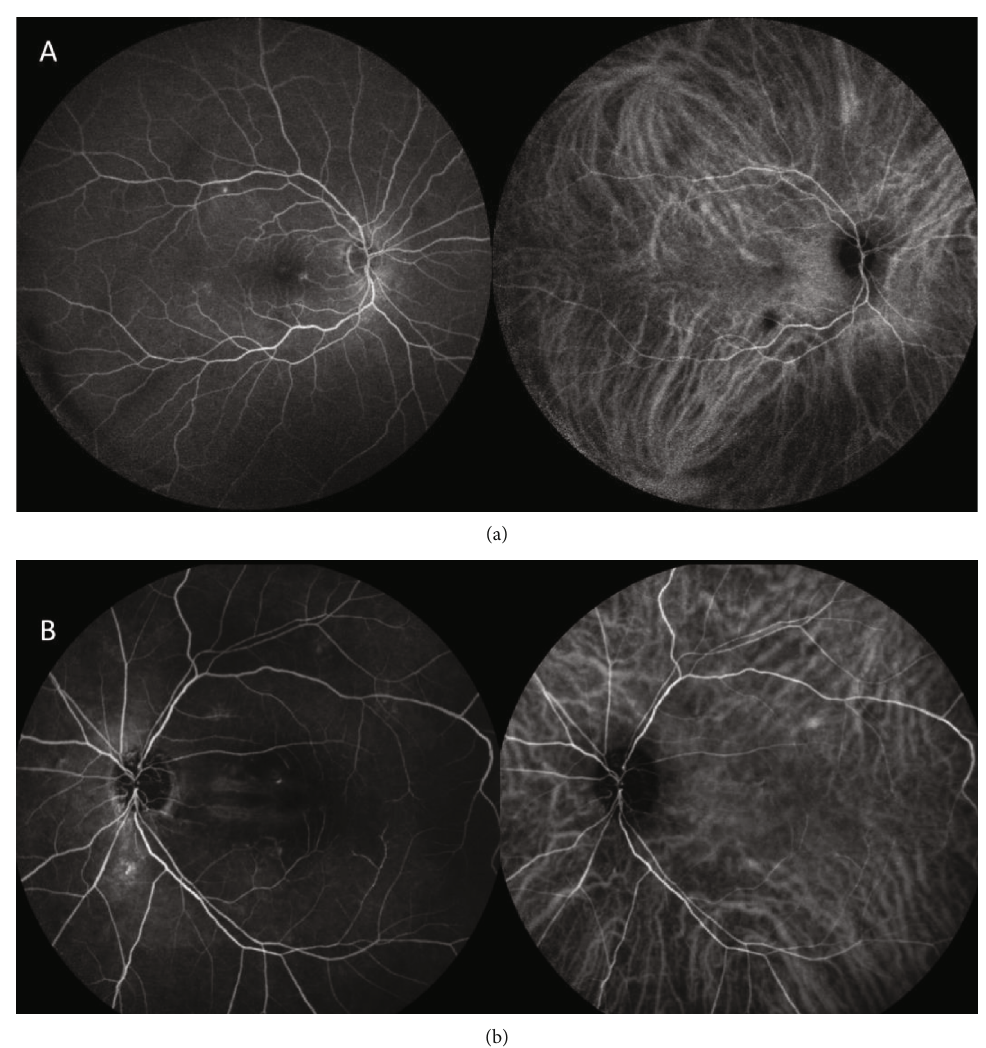
Figure 1: Images 5 months before the diagnosis of the metastatic lesion in the right eye (RE). (a) Midphase wide fi eld FA and ICG of the RE showing discrete hyper fl uorescent spots (transmission defects) in the arcades. Hypo fl uorescent plaque on ICG in the inferior temporal vascular arcade, with no relevant fi ndings on multimodal OCT. (b) Late arterial phase FA and ICG of the left eye showing narrow arterial vessels and horizontal hyper fl uorescent tracks due to RPE atrophy in the central